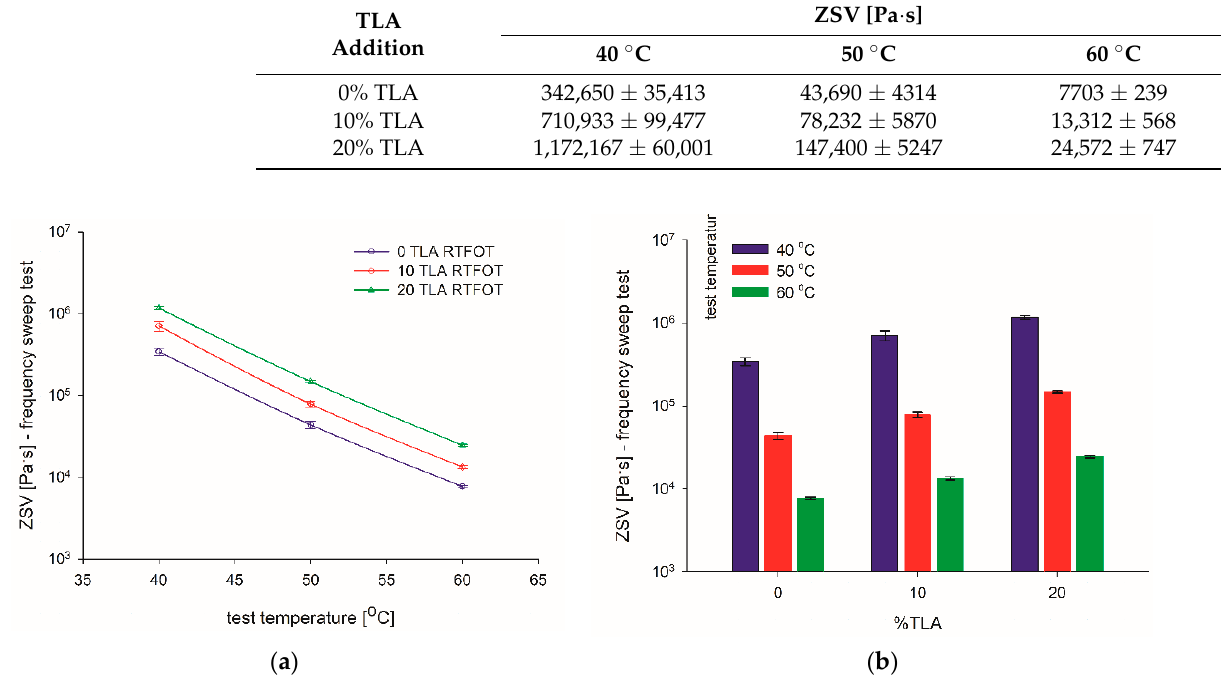
Figure 2. ( a ) Penetration and ( b ) softening point after RTFOT ageing of TLA-modified binders with different TLA content. Table 4. Physical properties of TLA-modified binders after RTFOT ageing.